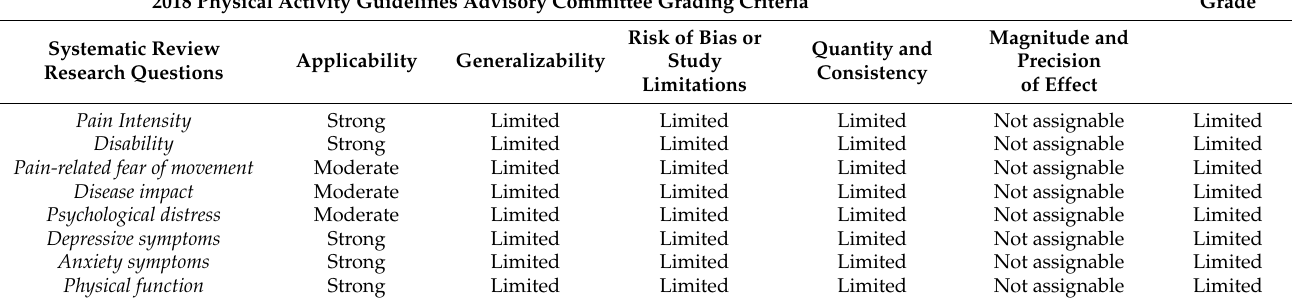
Table 5. Summary of findings and quality of evidence (PAGAC).